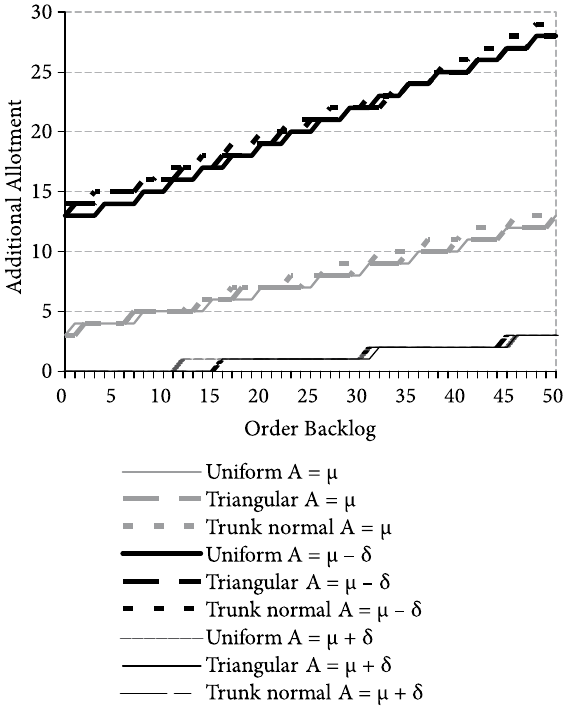
Fig. 4. Optimal additional allotment for given backlog when additional allotment cost function is R 2 + R and backlogged cost 3 B